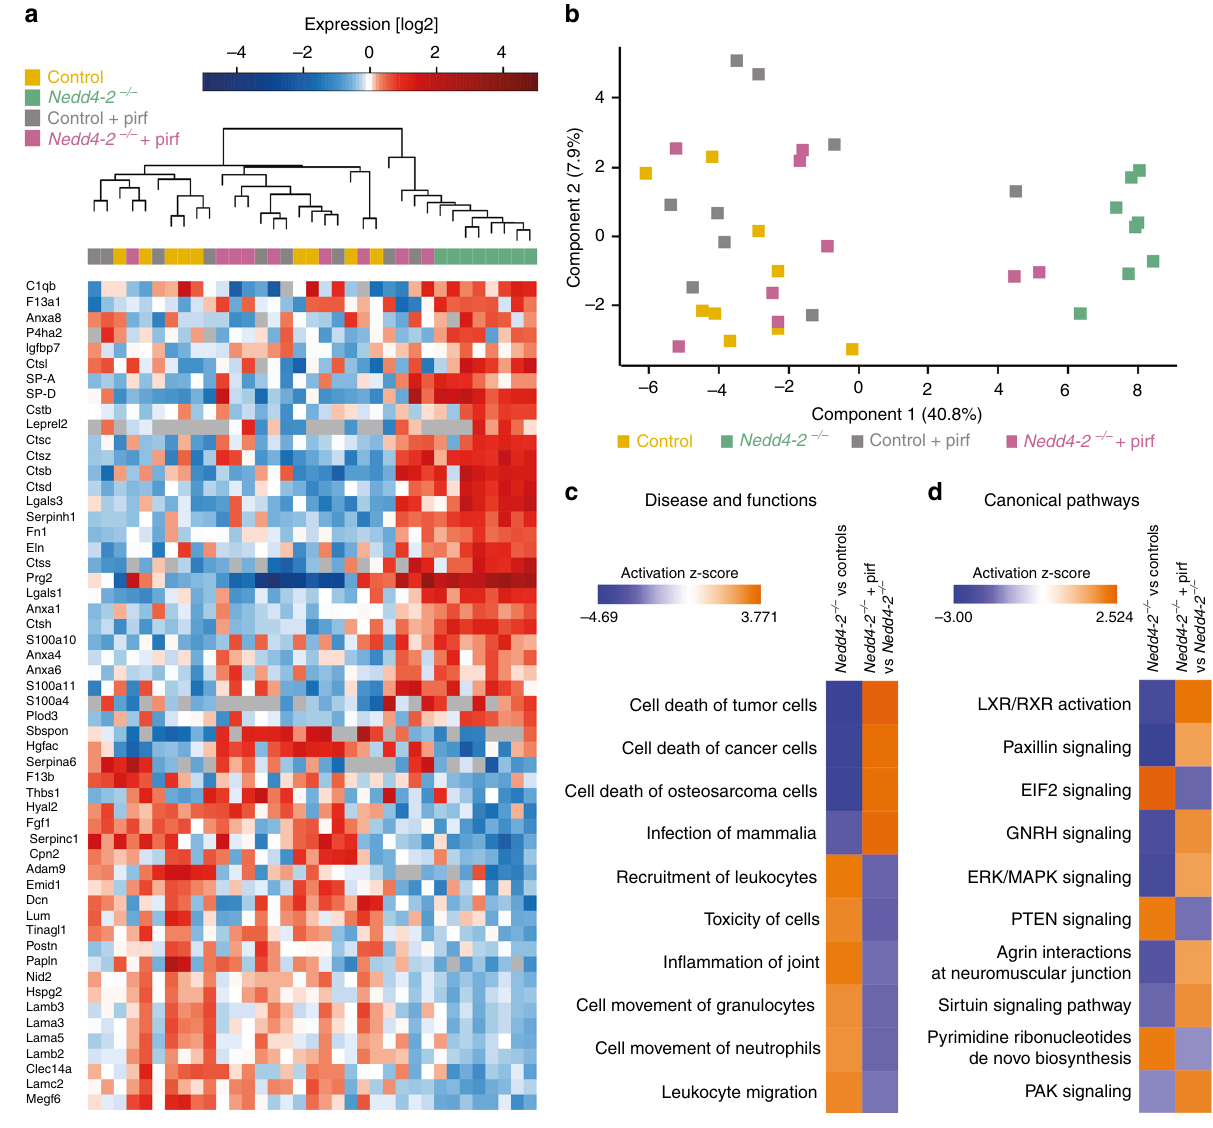
Fig. 9 Pirfenidone treatment reverts proteomic changes associated with pulmonary fi brosis in conditional Nedd4-2 − / − mice. a Heatmap of differentially regulated matrisome annotated proteins in lungs of 3-months doxycycline-induced conditional Nedd4-2 − / − and control mice treated with pirfenidone (pirf) or vehicle alone ( n = 9/group and Nedd4-2 − / − vehicle, n = 8). b Principal component analysis of all signi fi cantly regulated proteins. c , d Ingenuity Pathway Analysis of signi fi cantly regulated proteins in the four experimental groups. Top enriched diseases and functions ( c ) and canonical pathways ( d ) based on the predicted activation z -score are